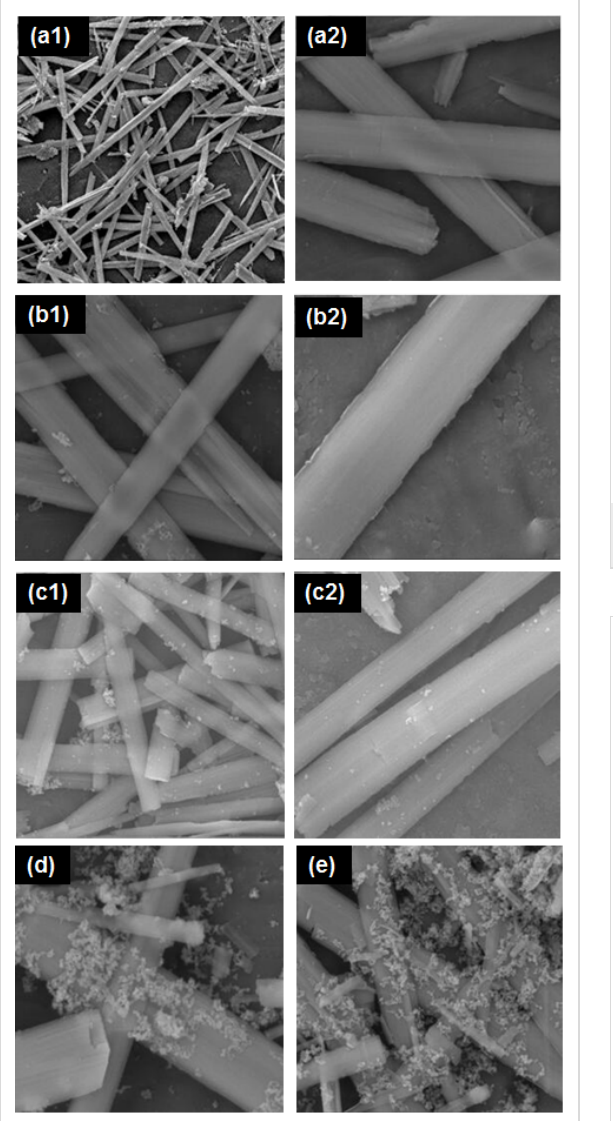
Figure 3: SEM images (some with higher resolution) of different ZnO loadings on KNb 3 O 8 nanosheets: (a) 0 wt %; (b) 1 wt %; (c) 2 wt %; (d) 3 wt %; (e) 4 wt %.